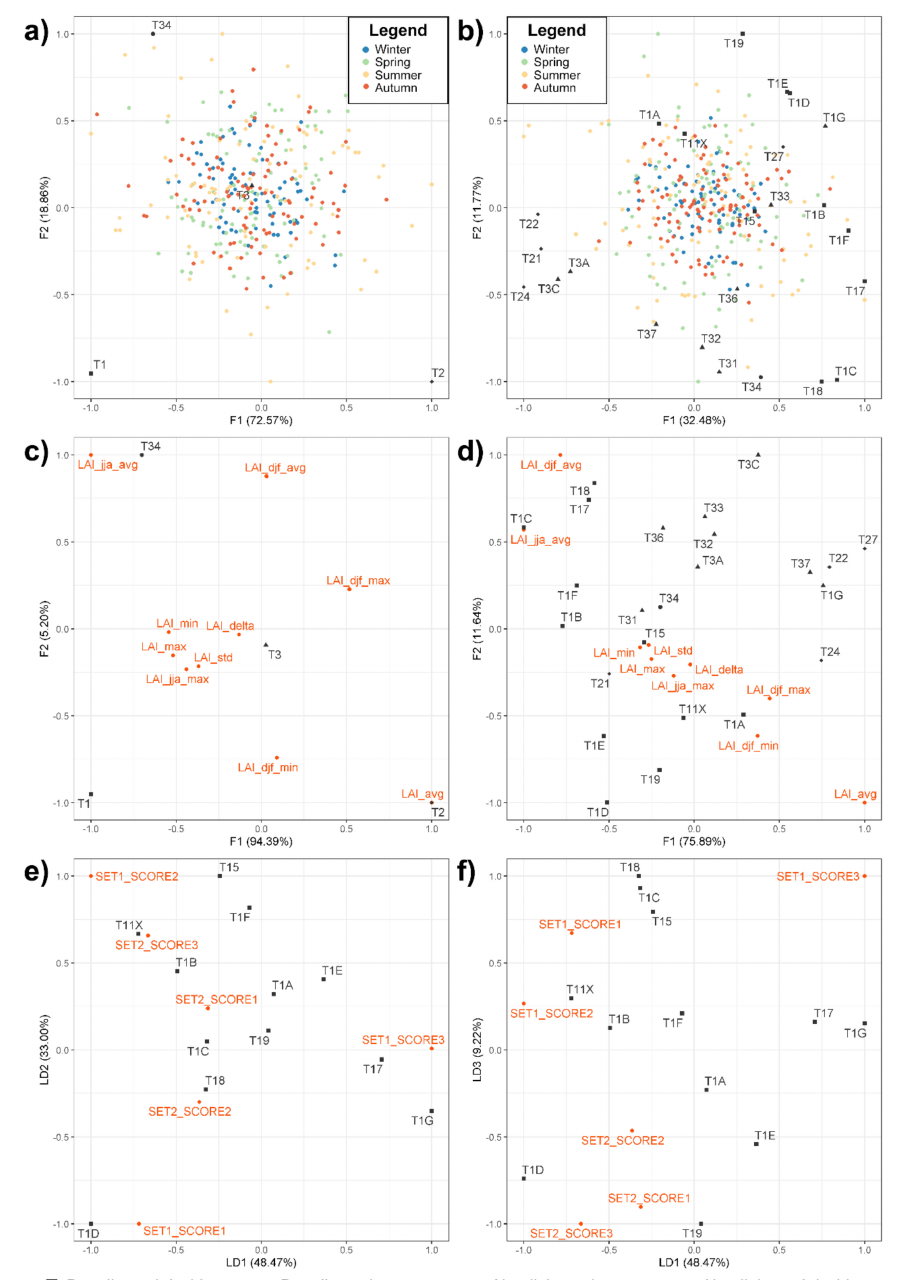
Figure 6. Biplots showing results of multivariate analysis. ( a ) Distribution of centers of gravity (black squares) for the EUNIS level II forest classes and LAI daily time series daily (colored dots) according to the first two DFA factors; ( b ) distribution of centers of gravity (black squares) for the EUNIS level III forest classes and LAI daily time series (colored dots) according to the first two DFA factors; ( c ) distribution of centers of gravity (black squares) for the EUNIS level II forest classes and LAI temporal statistics (colored dots) according to the first two DFA factors; ( d ) distribution of centers of gravity (black squares) for the EUNIS level III forest classes and LAI temporal statistics (red dots) according to the first two DFA factors; ( e ) distribution of centers of gravity (black squares) for the deciduous broadleaved (T1) forest classes and the sets of independent axes derived from CCA (red dots) according to the first two LDA factors; ( f ) distribution of centers of gravity (black squares) for the deciduous broadleaved (T1) forest classes and the sets of independent axes derived from CCA (red dots) according to the first and the third LDA